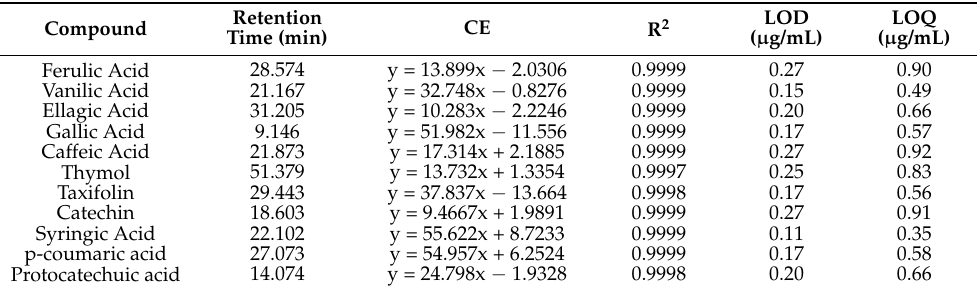
Table 2. Analytical merits of the HPLC method [limit of detection (LOD), limit of quantification (LOQ), calibration equation (CE), and square of correlation coefficient (R 2 )].